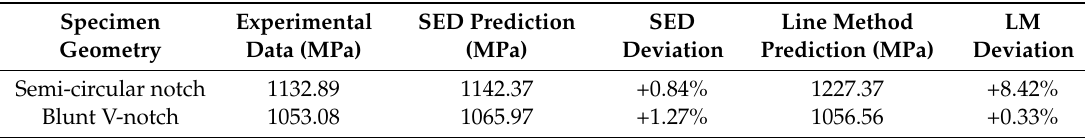
Table 3. Prediction of tensile failure of specimens weakened by a semi-circular and blunt V-notch using the SED approach and the line method.